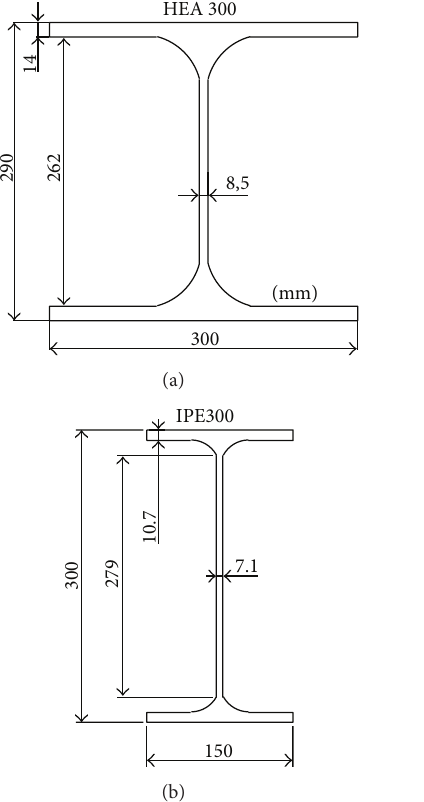
Figure 2: (a) Beam section; (b) column section.